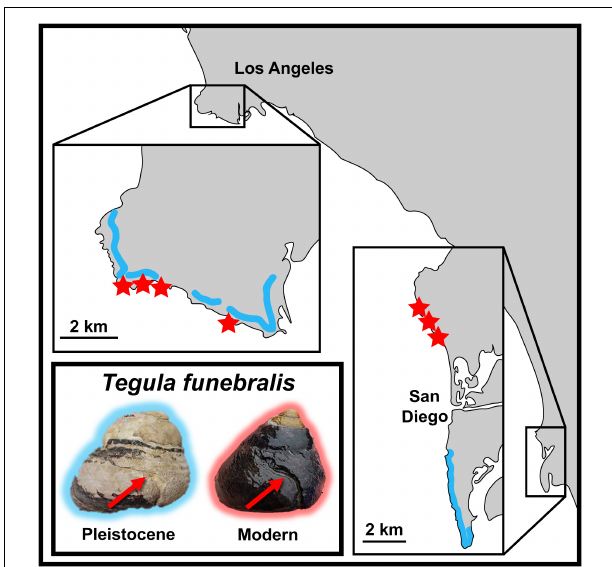
FIGURE 1 | Map of southern California between Los Angeles and San Diego with images of fossil and modern T. funebralis with repair scars. Red arrows on T. funebralis indicate location of repair scars (wedge-shaped scar/line on body whorl). Map insets show the two study areas (Palos Verdes Hills and San Diego) in more detail. Modern localities are indicated in red stars (four from the Palos Verdes Hills area, and three from north of San Diego). Approximate fossil localities are indicated by blue lines which indicate the terraces and/or GPS coordinate information that accompanied fossil lots. Terraces in the Palos Verdes Hills are based on Figure 6 of Muhs et al.